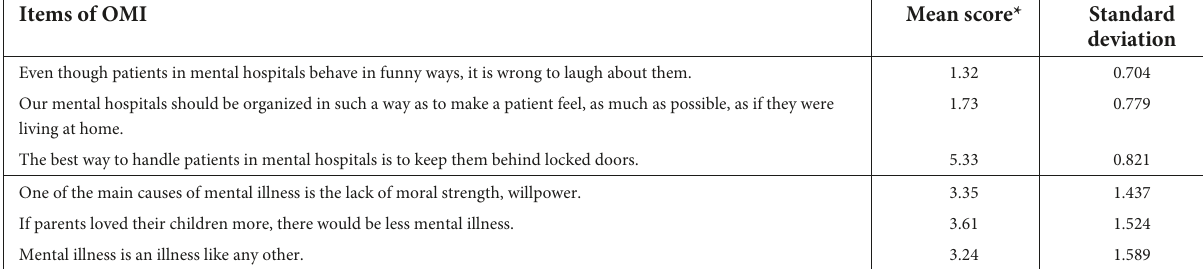
TABLE 2 Items of maximum and minimum standard deviations in OMI analysis. Items of OMI Mean score* Standard